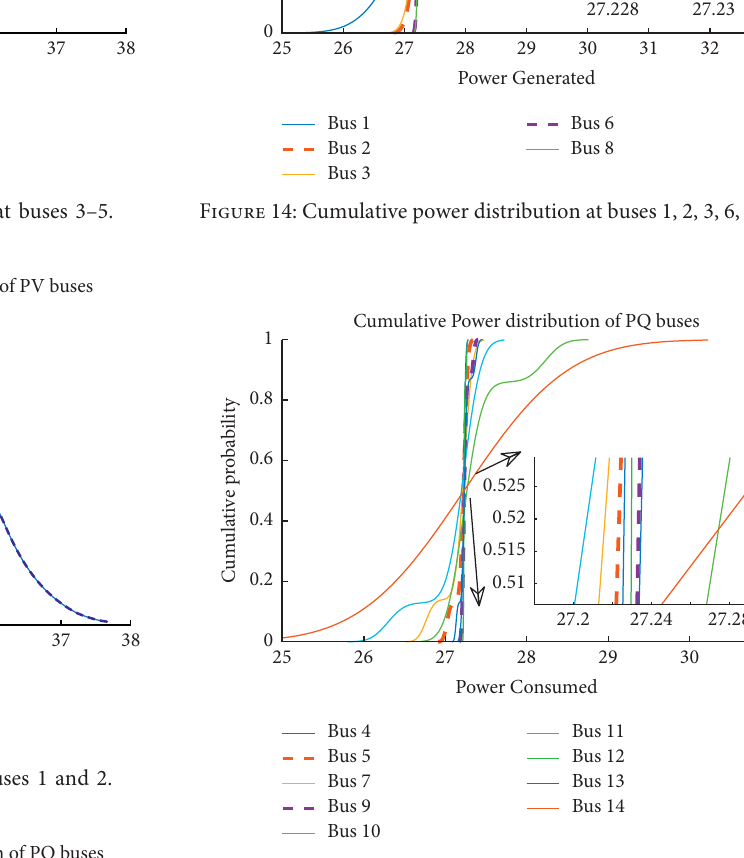
Figure 15: Cumulative power distribution at buses 4, 5, 7, and